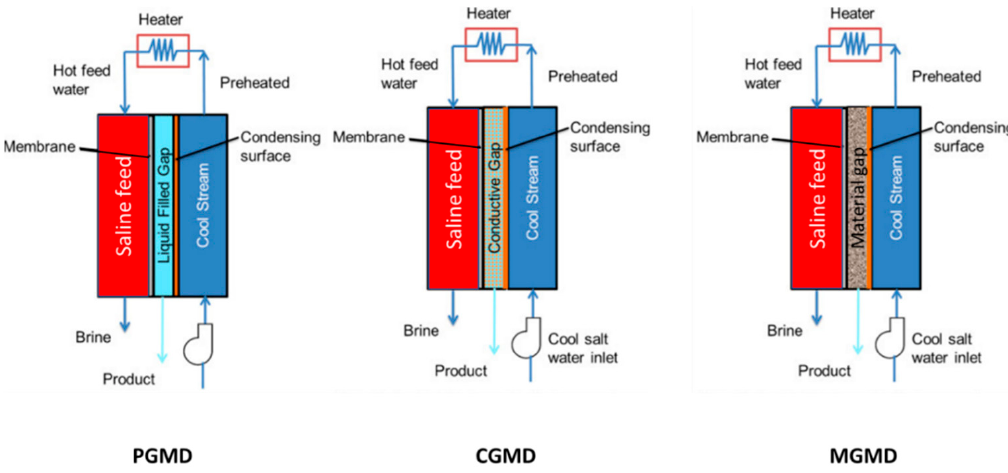
Figure 3. PGMD, CGMD, and MGMD configurations. Adapted from [14]. Copyright (2016) with permission from Elsevier .